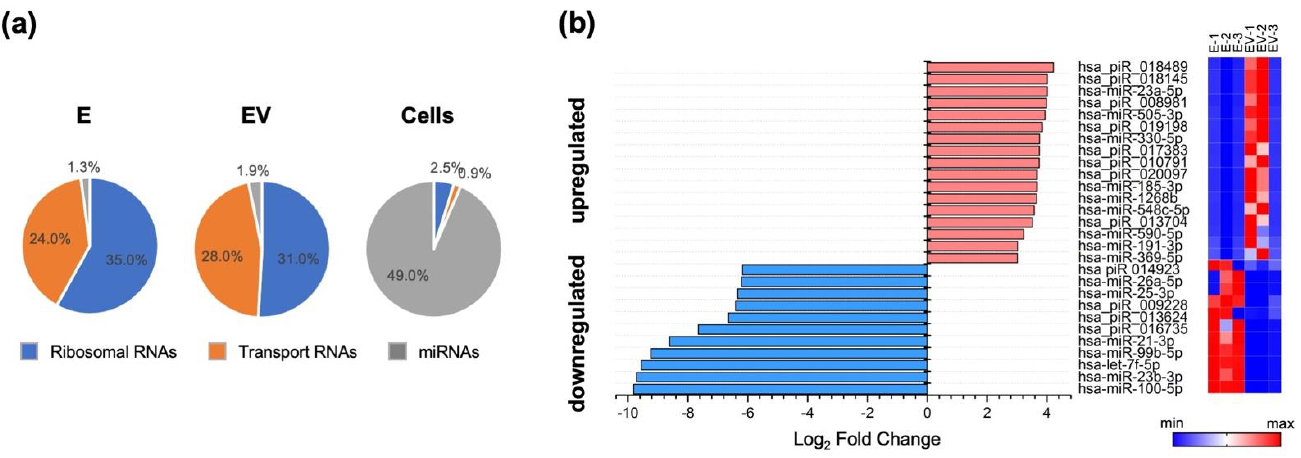
Figure 1. ( a ) Different types of RNA levels in exosomes samples (E—exosomes from mock-infected cells; EV—infected-cell-secreted exosomes), compared to control cells (‘Cells’). For the three pie charts, the unshown percentages adding up to 100% (39.7%, 39.1%, 47.6%) correspond to meaningless reads (no adapter, too short, UMI defective reads, uncharacterized sequences). ( b ) MicroRNAs upregulated (log 2 fold change > 1) and downregulated (log 2 fold change < 1) after influenza A infection of A549 cells. Heat maps present the level of miRNA expression: E-1, E-2 and E-3—three independent samples of exosomes from mock-infected cells; EV-1, EV-2 and EV-3—three independent samples of infected-cell-secreted exosomes.